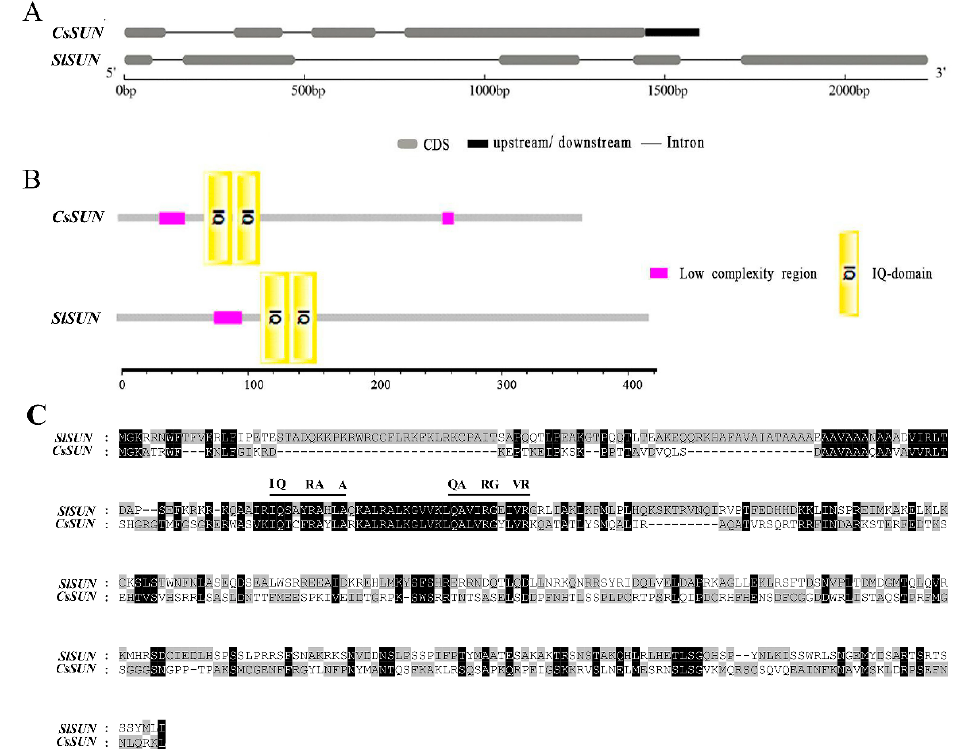
Figure 1. Gene and protein structures of CsSUN and SlSUN . ( A ) Gene structure comparison between CsSUN and SlSUN genes. ( B ) Conservative domains in SlSUN and CsSUN proteins. ( C ) Amino acid sequence comparison between SlSUN and CsSUN. The IQ domains are labelled on the top of corresponding amino acids with black